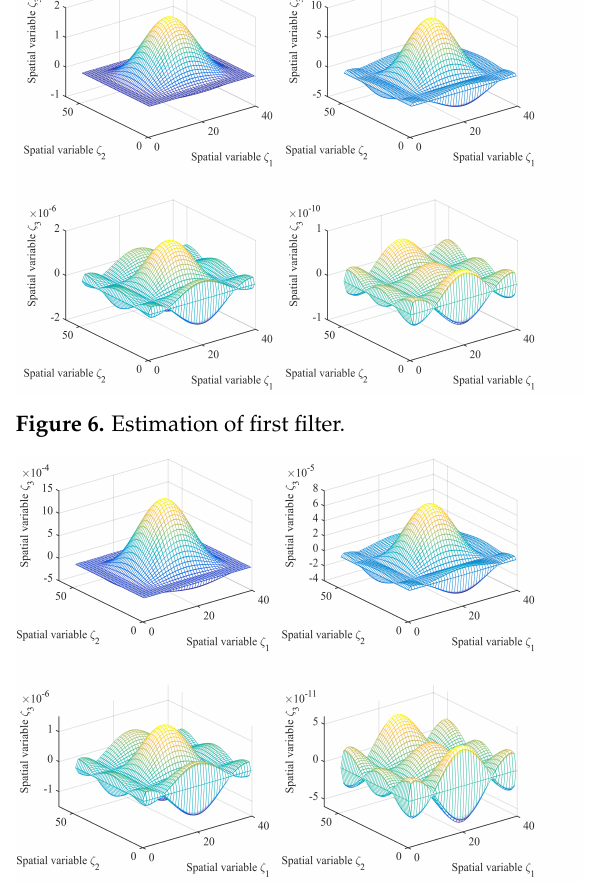
Figure 7. Estimation of second filter.